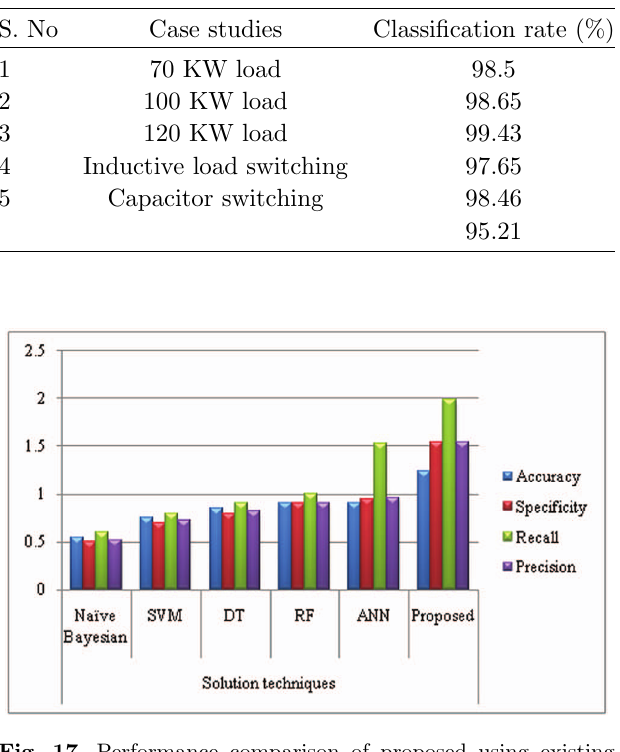
Table 3. Detection results of proposed technique.